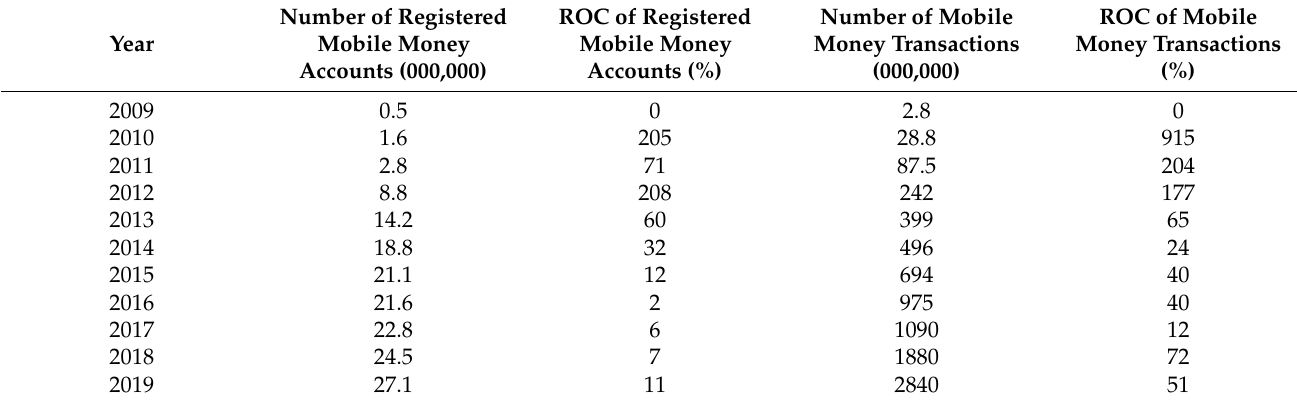
Table 7. Growth in mobile money accounts and mobile money transactions.